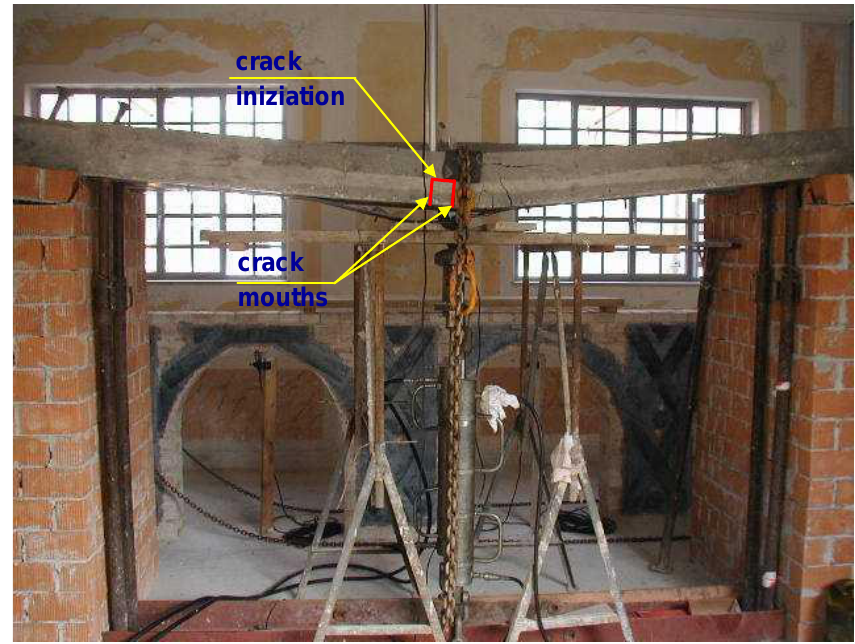
Figure 7. Experimental verification of the analytical model performed by means of four specimens tested up to collapse. The four beams were initially subjected to a two-point load, which produced vertical cracks around the midspan. Then, two beams were left unstrengthened, and two beams were strengthened in the fashion described in Section 4 (side-bonded reinforcement). Finally, a vertical force was applied to the midspan of each beam (pistons and actuators are shown in the picture) and was increased to failure. Once the side-bonded reinforcement debonded, the applied load caused the entire beam to collapse. The last event that led to the collapse of the beam was debonding of the longitudinal external FRP reinforcement applied on the lower side of the beam. Nevertheless, debonding of the flexural FRP reinforcement occurred after debonding of the shear CFRM reinforcement, when the load-carrying capacity was almost